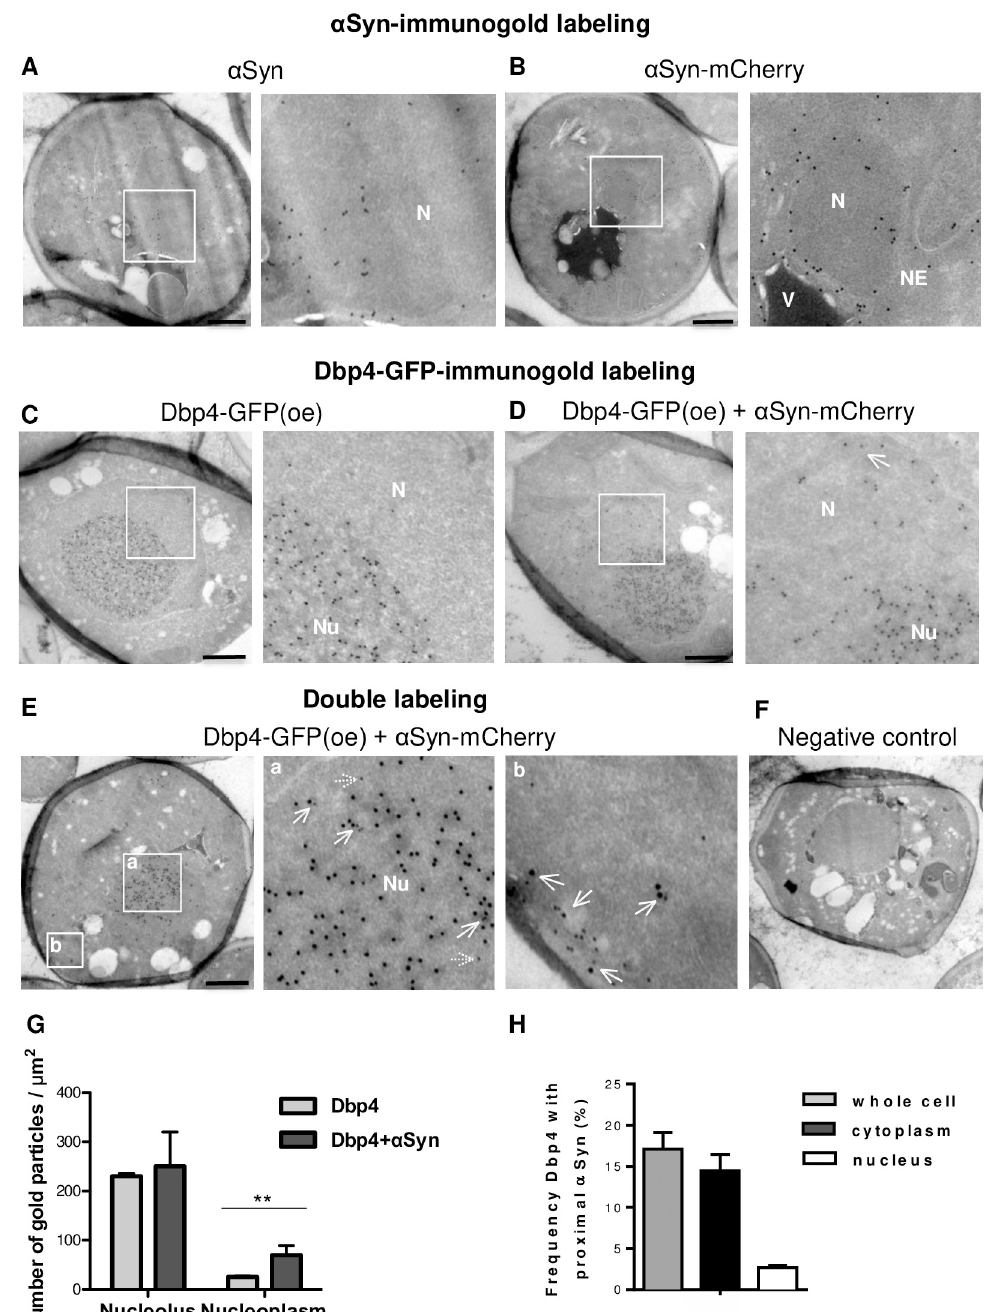
Fig 6. α Syn sequesters Dbp4 outside the nucleolus. Representative electron micrographs showing immunogold labeling of α Syn, α Syn-mCherry and Dbp4-GFP in yeast cells. Right: micrographs with higher magnifications of indicated areas marked by white boxes. (A) α Syn-positive gold particles are in the nucleus. Nucleolus is not visible. (B) α Syn-mCherry shows similar subcellular localization as the untagged protein. (C) Overexpression (oe) of Dbp4-GFP and immunogold labeling results in nucleoli with high densities of gold particles, but only a few gold particles scattered in nucleoplasm. (D) Co-expression of Dbp4-GFP and α Syn-mCherry. Gold particles are distributed in nucleoplasm with higher density. (E) Double immuno-labeling of α Syn and Dbp4-GFP. 15 nm gold particles were used for GFP-labeling and 10 nm gold particles for α Syn labeling. Dashed arrows indicate single α Syn-gold particles; tick arrows indicate colocalization of α Syn and Dbp4-gold particles. N: nucleus; NE: nuclear envelope; Nu: nucleolus; V: vacuole. Scale bar = 500 nm. (F) Negative control for immuno-labeling. Yeast cells were processed as in (E), however the primary antibodies were omitted.